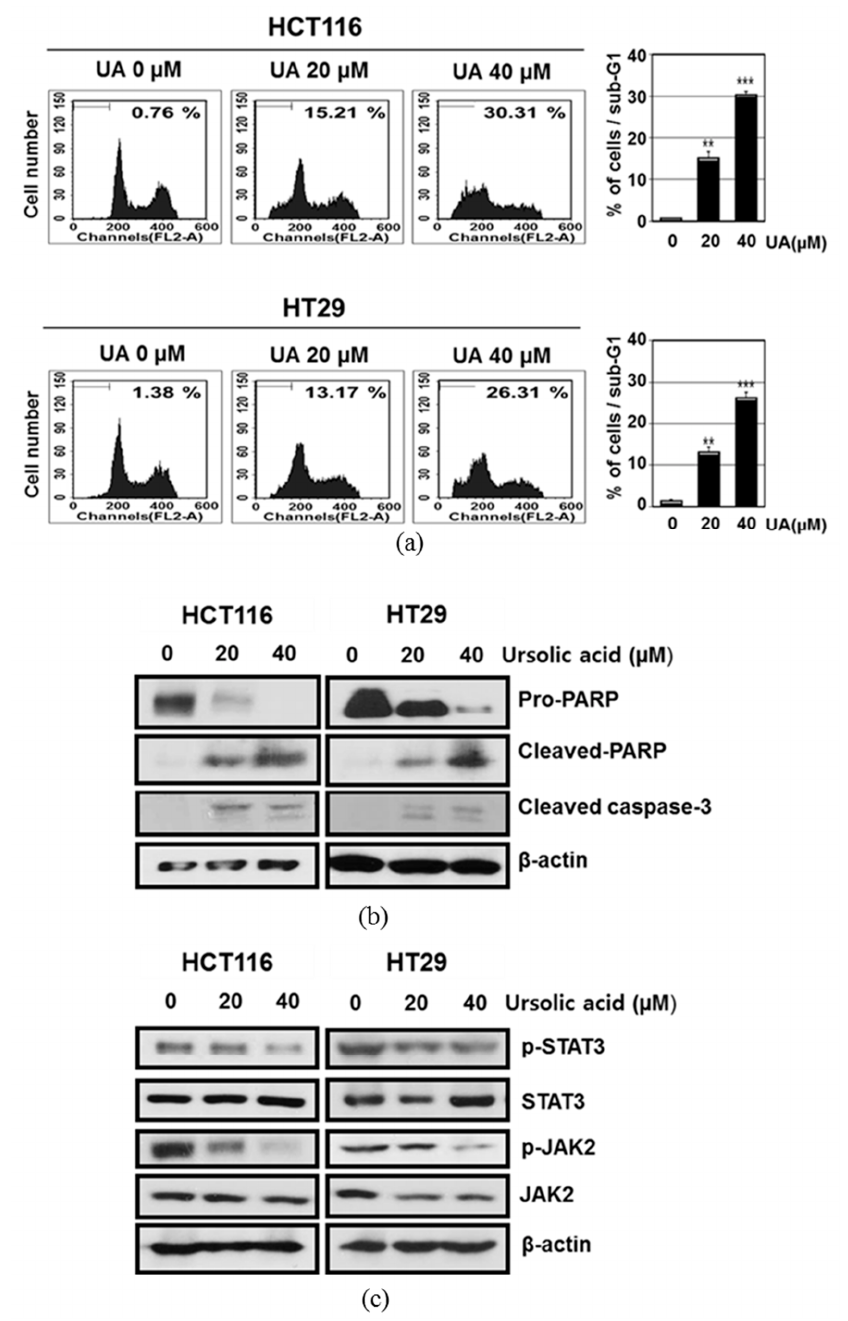
Figure 2. Effect of ursolic acid on the sub-G1 population and poly (adenosine diphosphate-ribose) polymerase (PARP), caspase 3, Janus kinase 2 (JAK2) and signal transducer and activator of transcription 3 (STAT3) in HCT116 and HT29 cells. ( a ) Effect of ursolic acid on sub-G1 population in HCT116 and HT29 cells. HCT116 and HT29 cells were treated with ursolic acid (20 and 40 µ M) for 24 h and stained with propidium iodide (PI). Flow cytometric analysis was conducted for the sub-G1 apoptotic portion in HCT116 and HT29 cells. Bar graphs represent the percentage of sub-G1 DNA contents undergoing apoptosis. Data represent means ± S.D. ** p < 0.01, *** p < 0.001. ( b ) Effect of ursolic acid on the cleavages of PARP and caspase-3 in HCT116 and HT29 cells. HCT116 and HT29 cells were treated with ursolic acid (0, 20, and 40 µ M) for 24 h. The cleavages of apoptosis-related proteins such as PARP and caspase-3 were measured by Western blot analysis. ( c ) Effect of ursolic acid on JAK2 and STAT3 signaling in HCT116 and HT29 cells. Western blotting was performed for p-STAT3, STAT3, p-JAK2, JAK2, and β